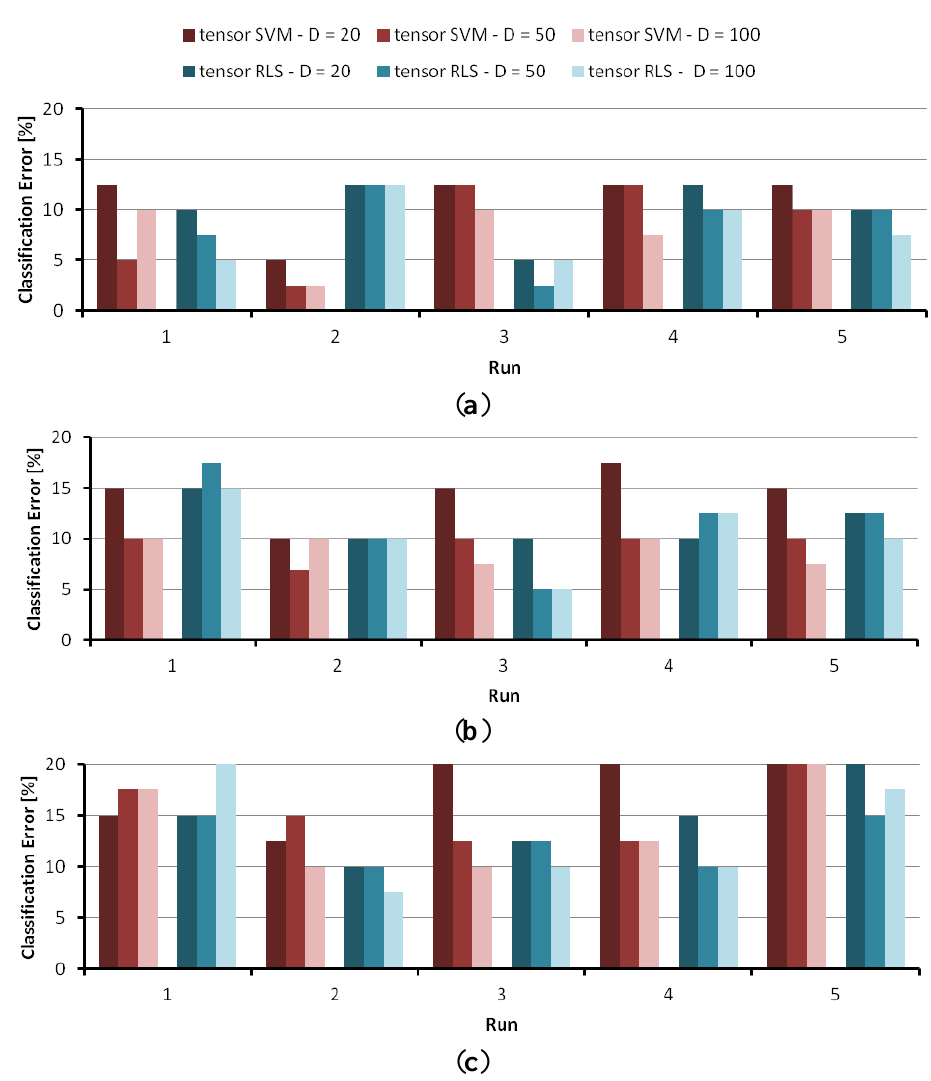
Figure 6. Results obtained with tensor-SVM and tensor-RLS for the